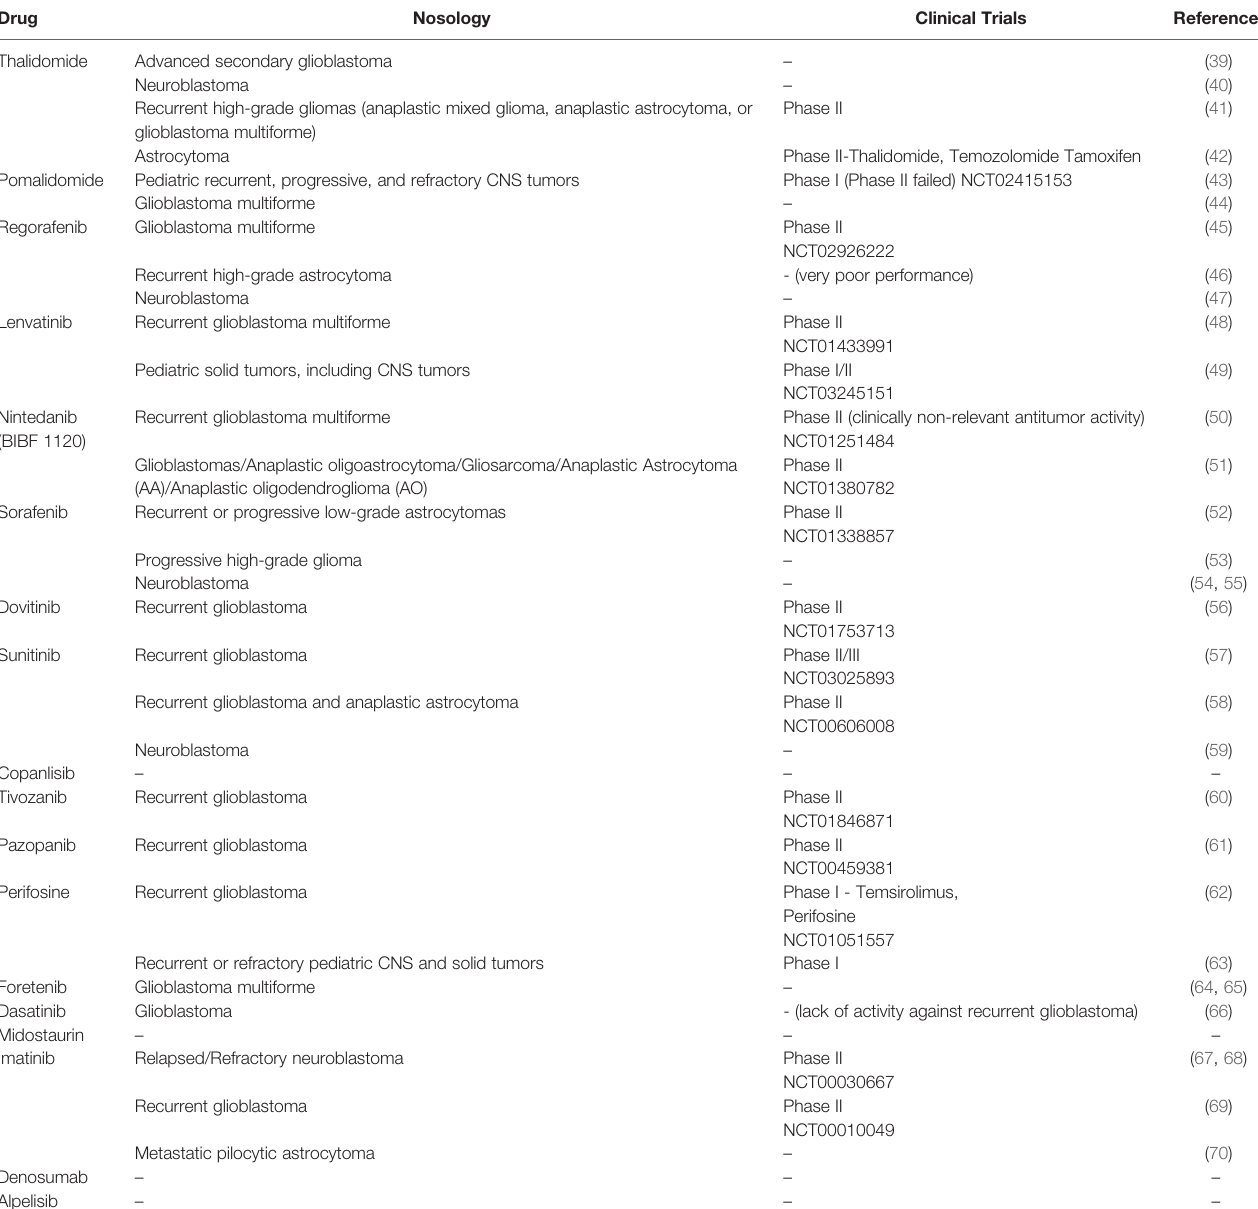
TABLE 1 | Overview of existing clinical trials conducted across Central Nervous System (CNS)-related tumors for target drugs with the highest drug score predicted for spinal intramedullary astrocytoma (SIA)